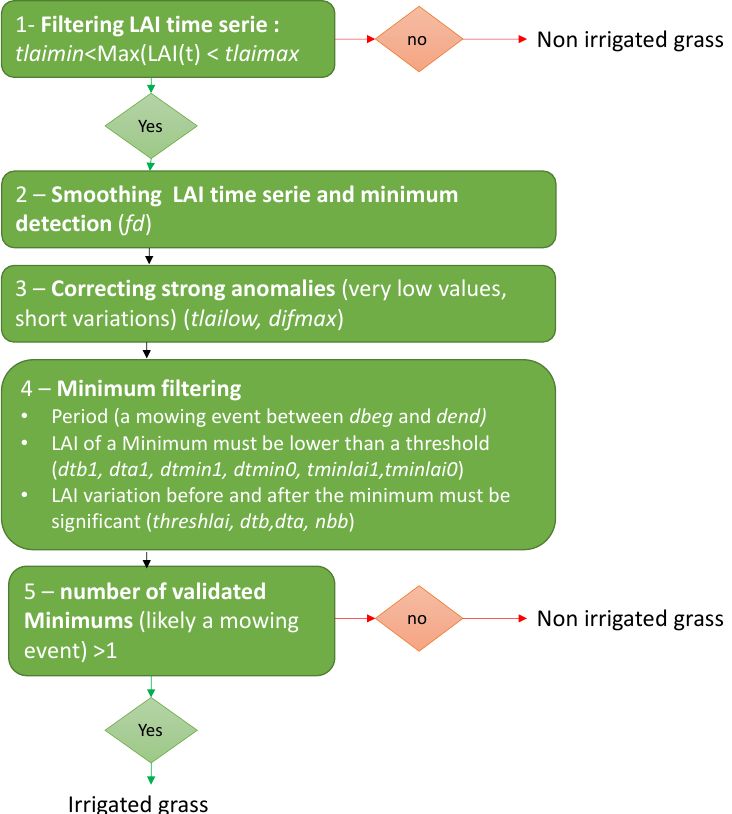
Figure 2. Five steps of the developed irrigated grassland algorithm at the pixel level. Step 5: The number of validated minimums, considered as mowing events, is estab- lished and used to apply the irrigated grassland filter being a minimum of two